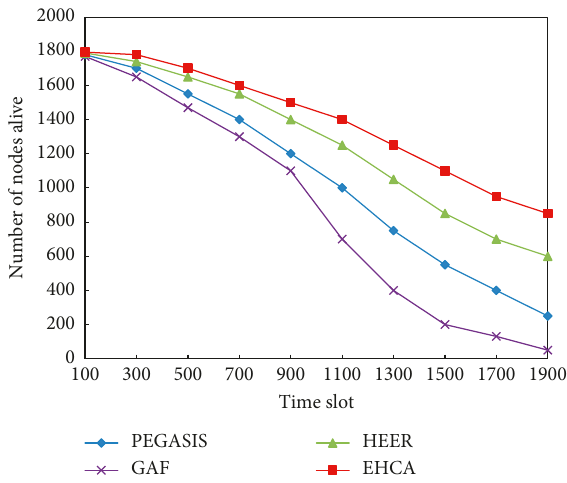
Figure 8: Number of nodes alive in the network per time slot.